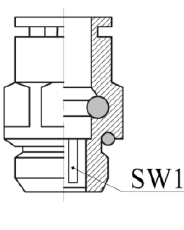
Figure 10. Dependence of air pressure distribution on the surface of an OM at different parameters of the geometry of the narrowing of the fitting. From the graph shown in Figure 10, it is clear that the pressure distribution on the surface of the object of manipulation changes only in the range of 13 to 18 mm on the supply side of compressed air (Figure 11).